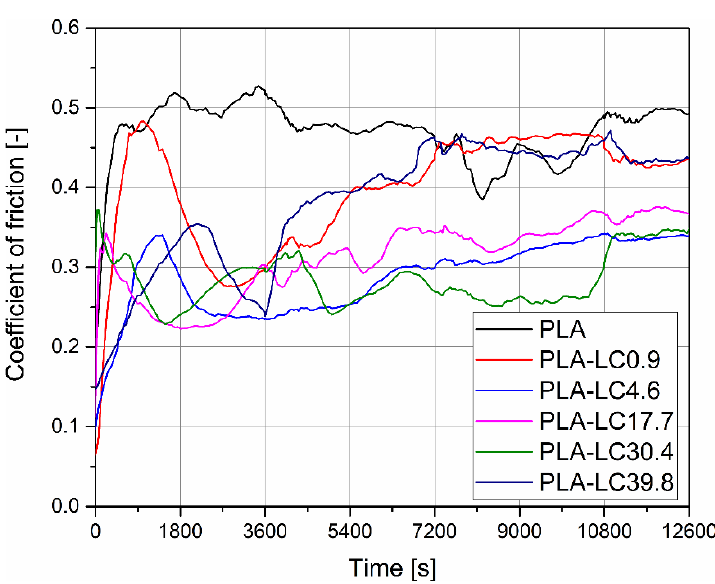
Figure 5. The changes of the coefficient of friction of PLA and its composites during the test.